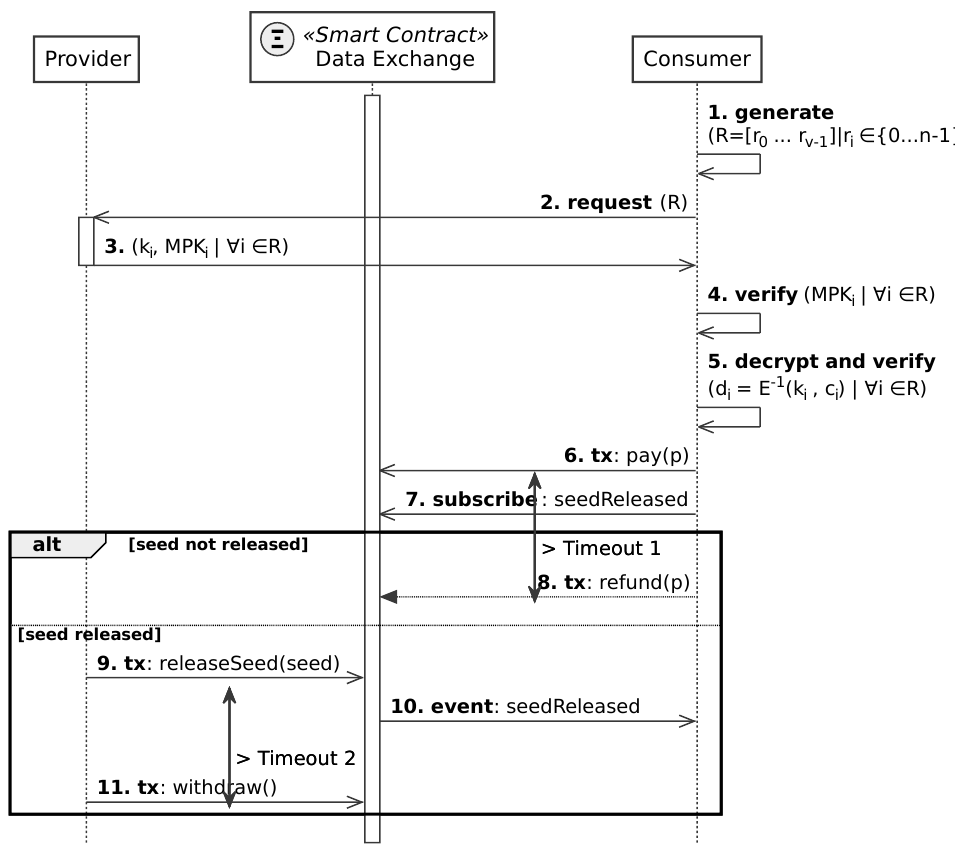
Figure 6. Protocol execution: sequence